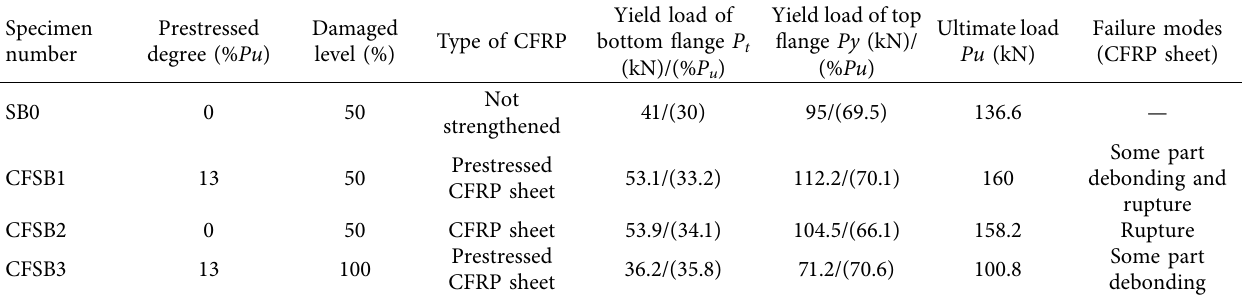
Table 1: Test matrix and results.